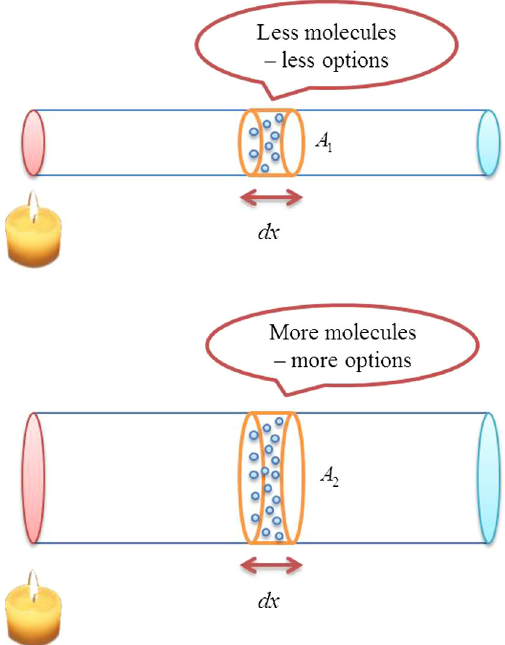
FIG. 2. The larger the cross section, the more collisions are